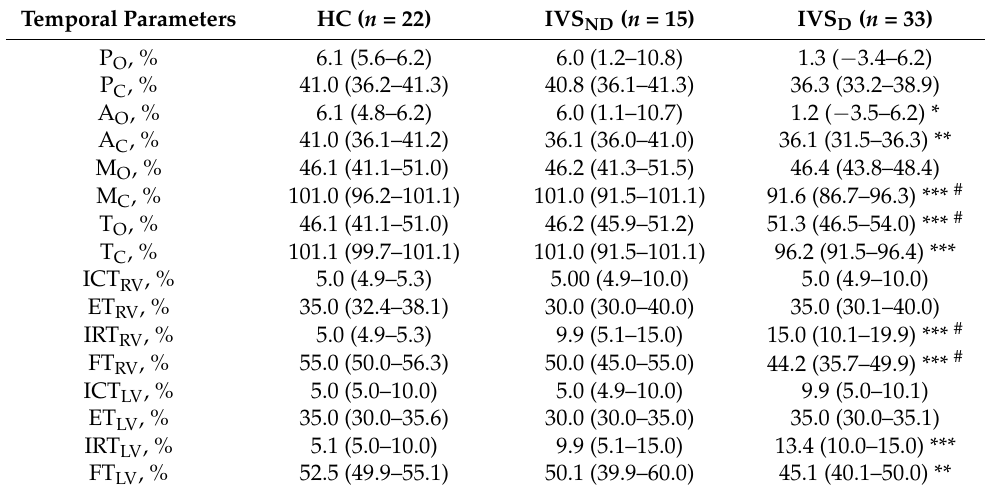
Table 3. CMR-derived temporal parameters of the three groups. Temporal